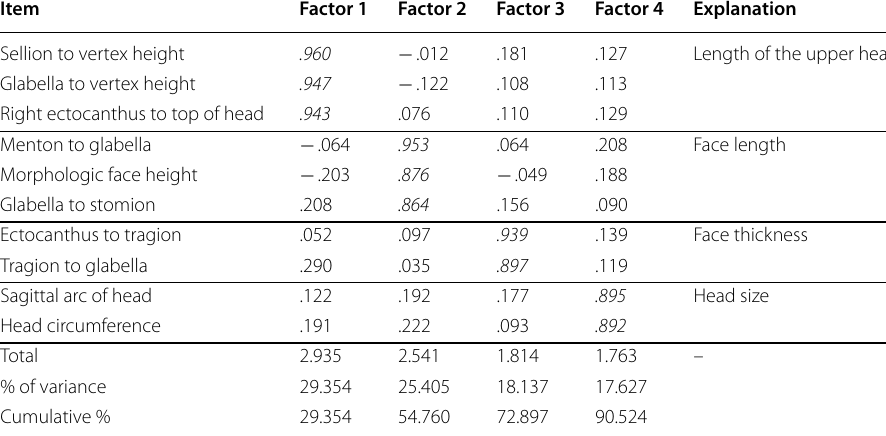
Table 2 Factor analysis results using absolute values